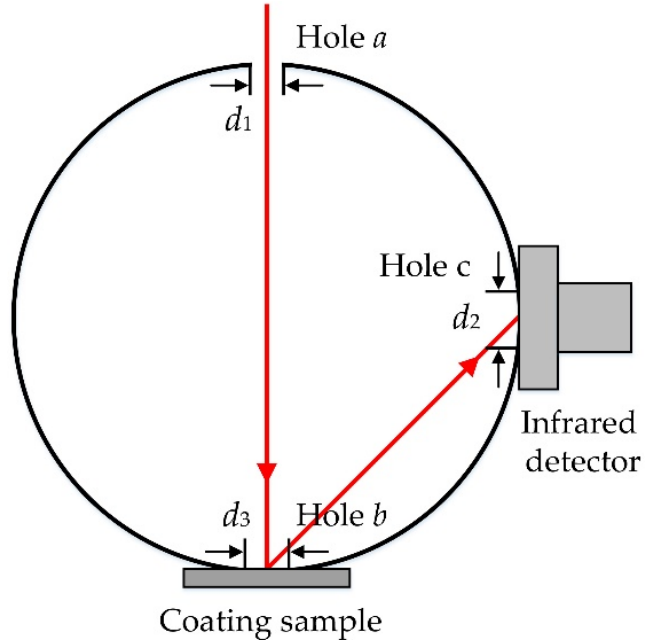
Figure 2. Reflection model of laser in three-hole integrating sphere.